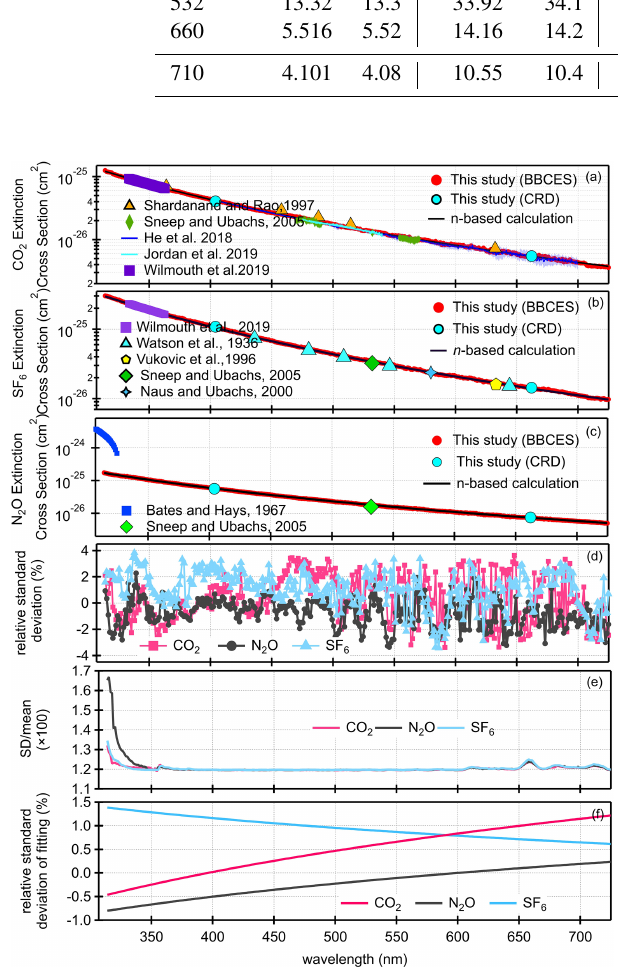
Figure 1. Rayleigh scattering cross sections of CO 2 (a) , SF 6 (b) , and N 2 O (c) . Panel (d) shows the relative standard deviations as a function of wavelength for each gas. The relative difference in the cross sections obtained by our measurements and calculations from the refractive index are displayed in panel (e) . Panel (f) shows the relative difference after fitting ( σ = Aλ B